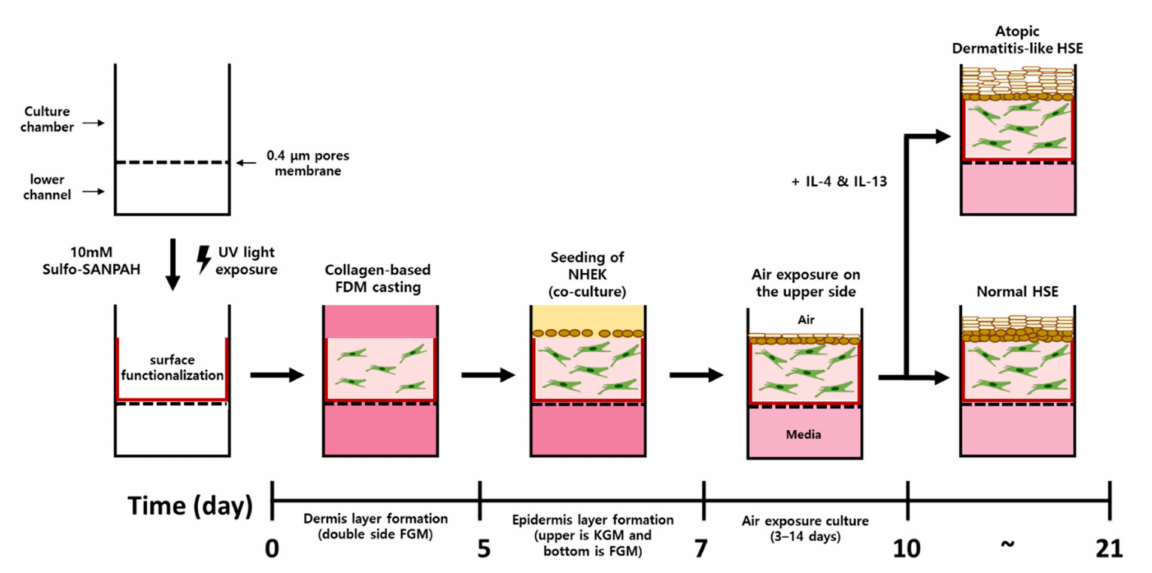
Figure 9. Schematic diagram of the AD-HSE formation process in the microphysiological system. The culture chamber of the pumpless SOC is shown for different incubation periods. The surface of the culture chamber is functionalized with Sulfo-SANPAH, and a dermal layer is formed for 5 days. On the 7th day after the start of culture, skin equivalents are formed through exposure to air and treated with the Th2 cytokines